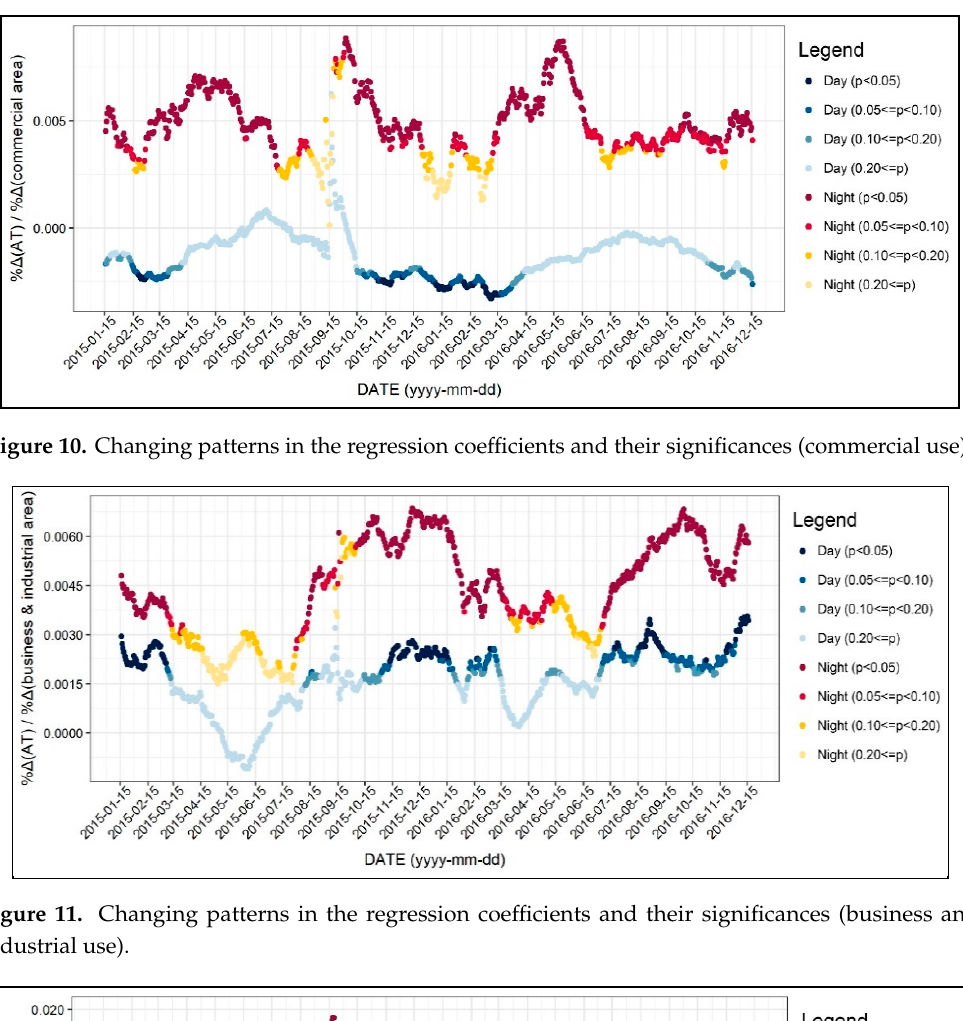
Figure 12. Changing patterns in the regression coefficients and their significances (traffic road area).